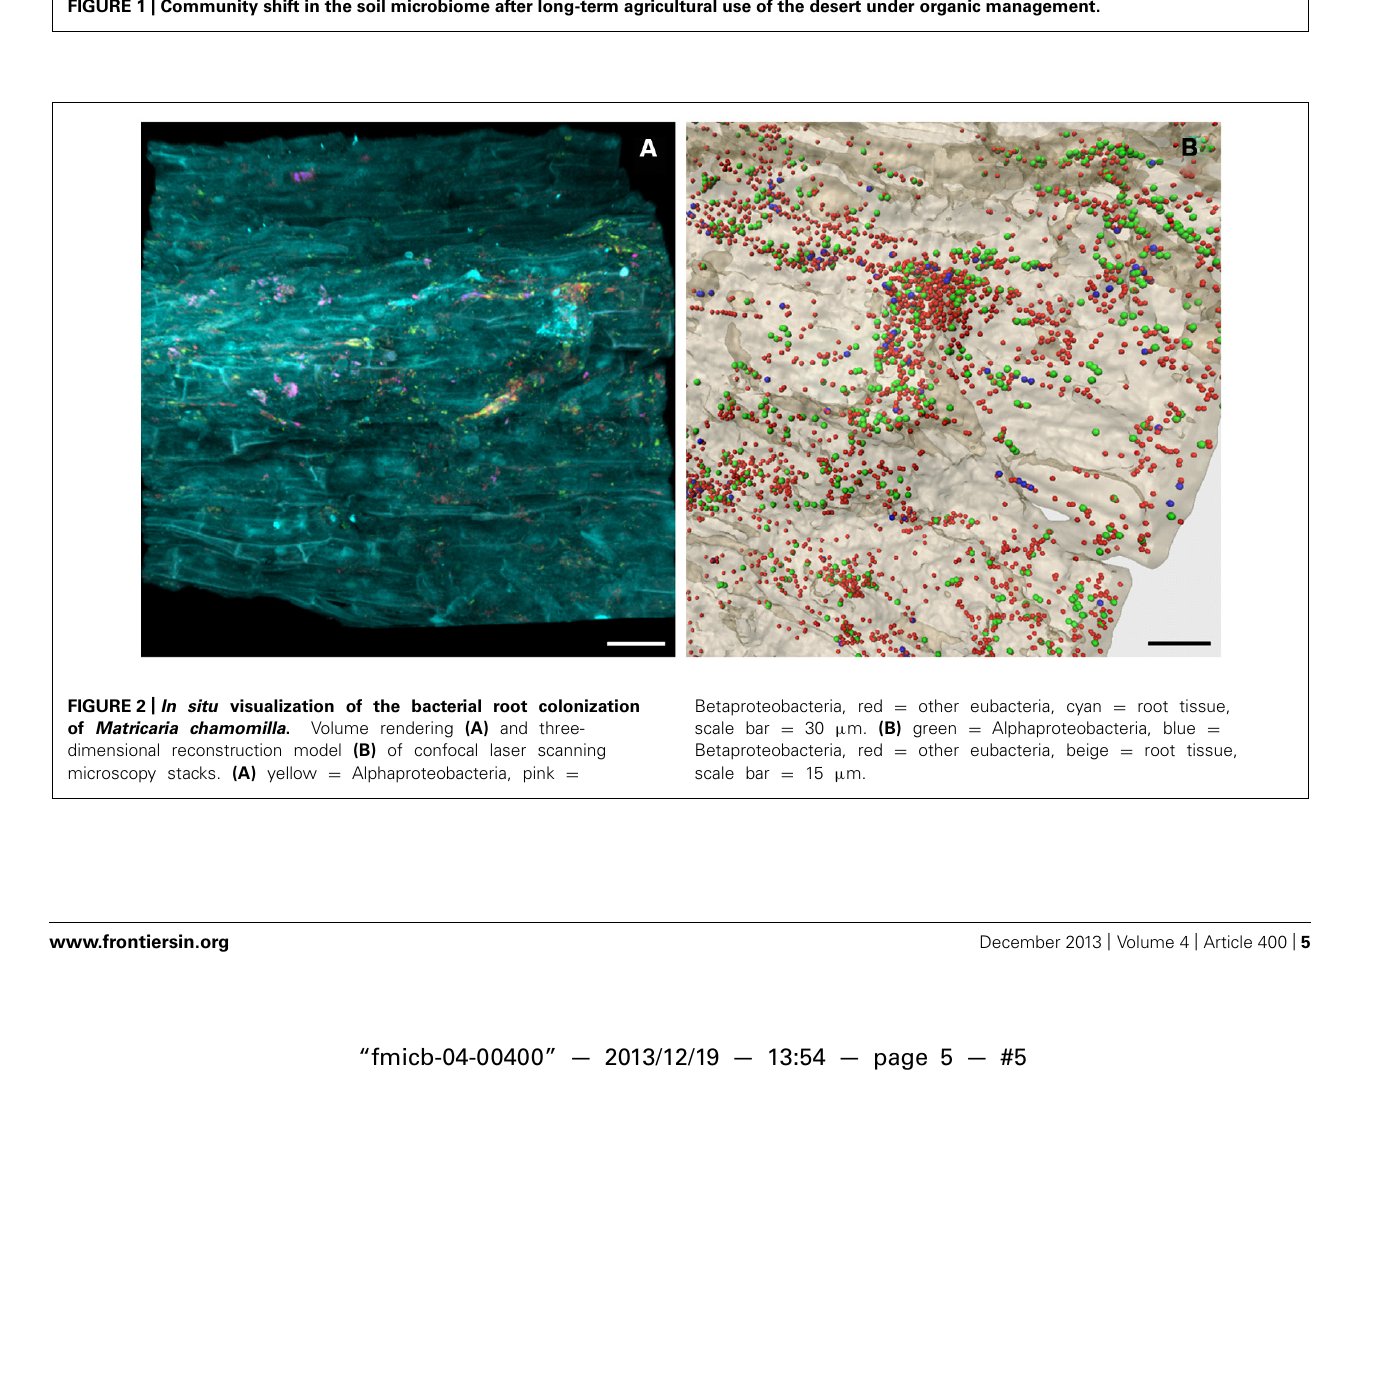
FIGURE 1 | Community shift in the soil microbiome after long-term agricultural use of the desert under organic management.